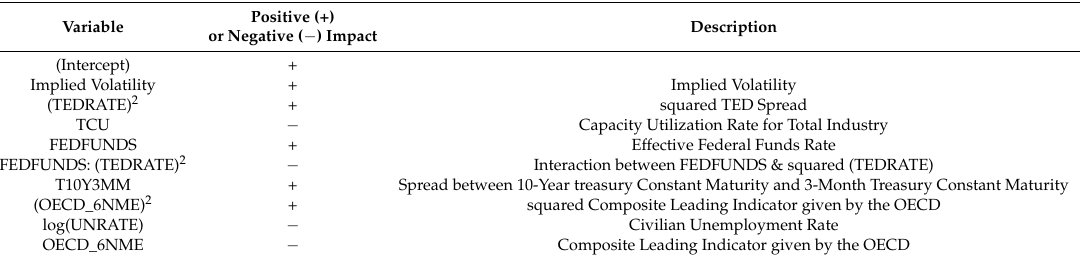
Table 1. Estimated logistic regression model for the Crisis